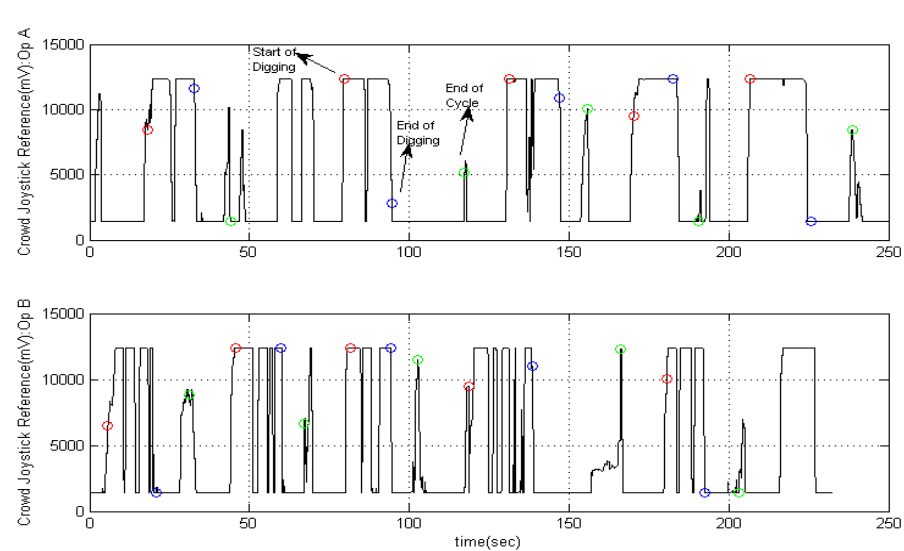
Figure 10. Crowd joystick reference.